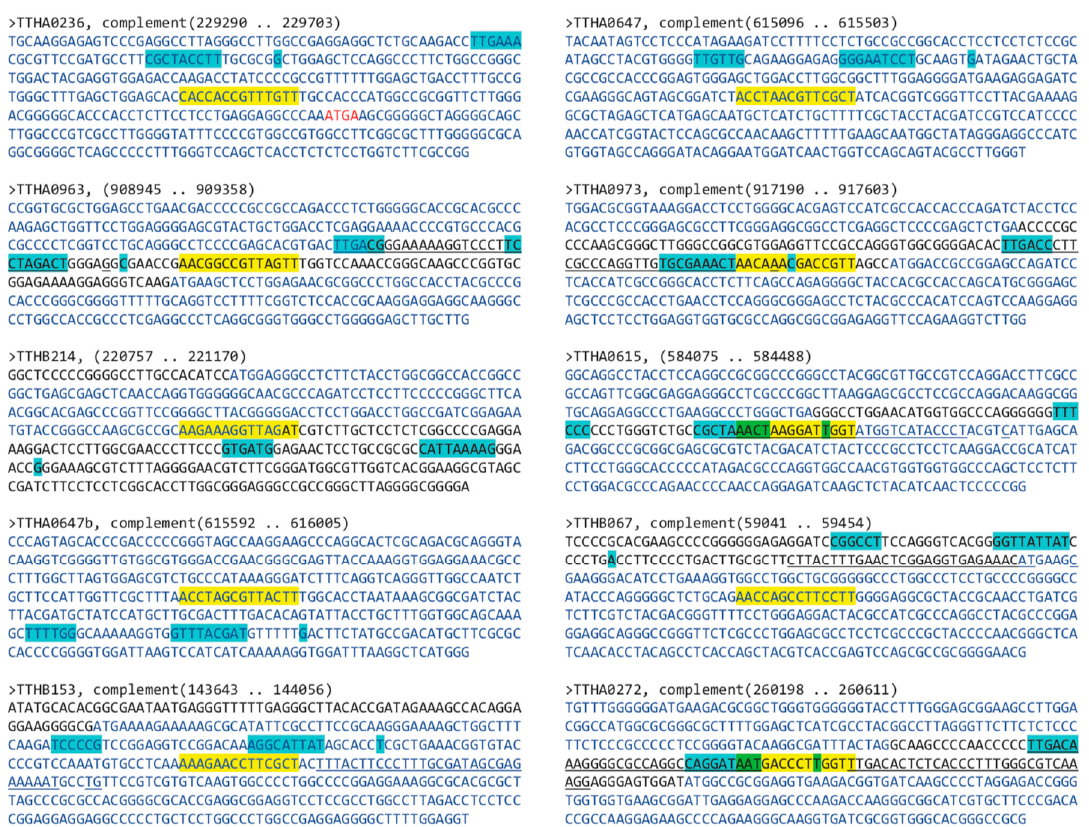
Figure 5. Bioinformatic identification of T. thermophilus HB8 promoters potentially regulated by TTHA0973. Shown are sequences +/ − 200 bp of the TTHA0973-binding sequence identified through FIMO (see Table 2). Longest open reading frames with the same orientation as the target gene are indicated with blue nucleotides. Black nucleotides indicate intergenic regions; red nucleotides, overlapping open reading frames. Potential promoter elements ( − 30 and − 10 boxes, + 1 start site of transcription) identified using Softberry BPROM are indicated with cyan highlighting; those identified by U. Groningen PePPER by underlining. TTHA0973-binding sites are indicated with yellow highlighting. Overlapping TTHA0973-binding and core promoter elements are indicated by green highlighting.